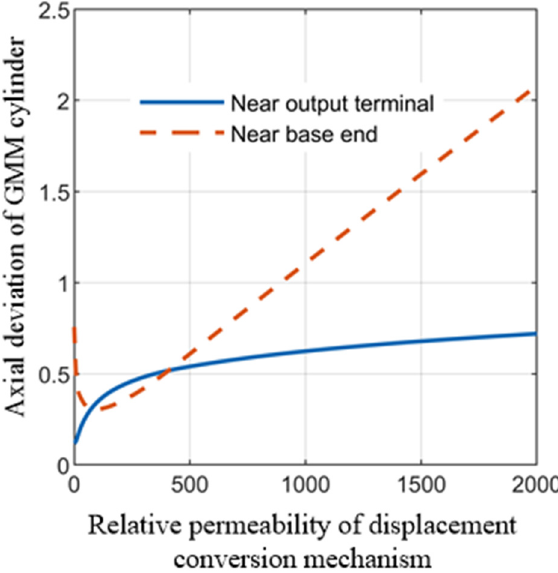
Figure 12. Influence of relative permeability of displacement conversion mechanism on deviation of axial magnetic density of GMM cylinder.